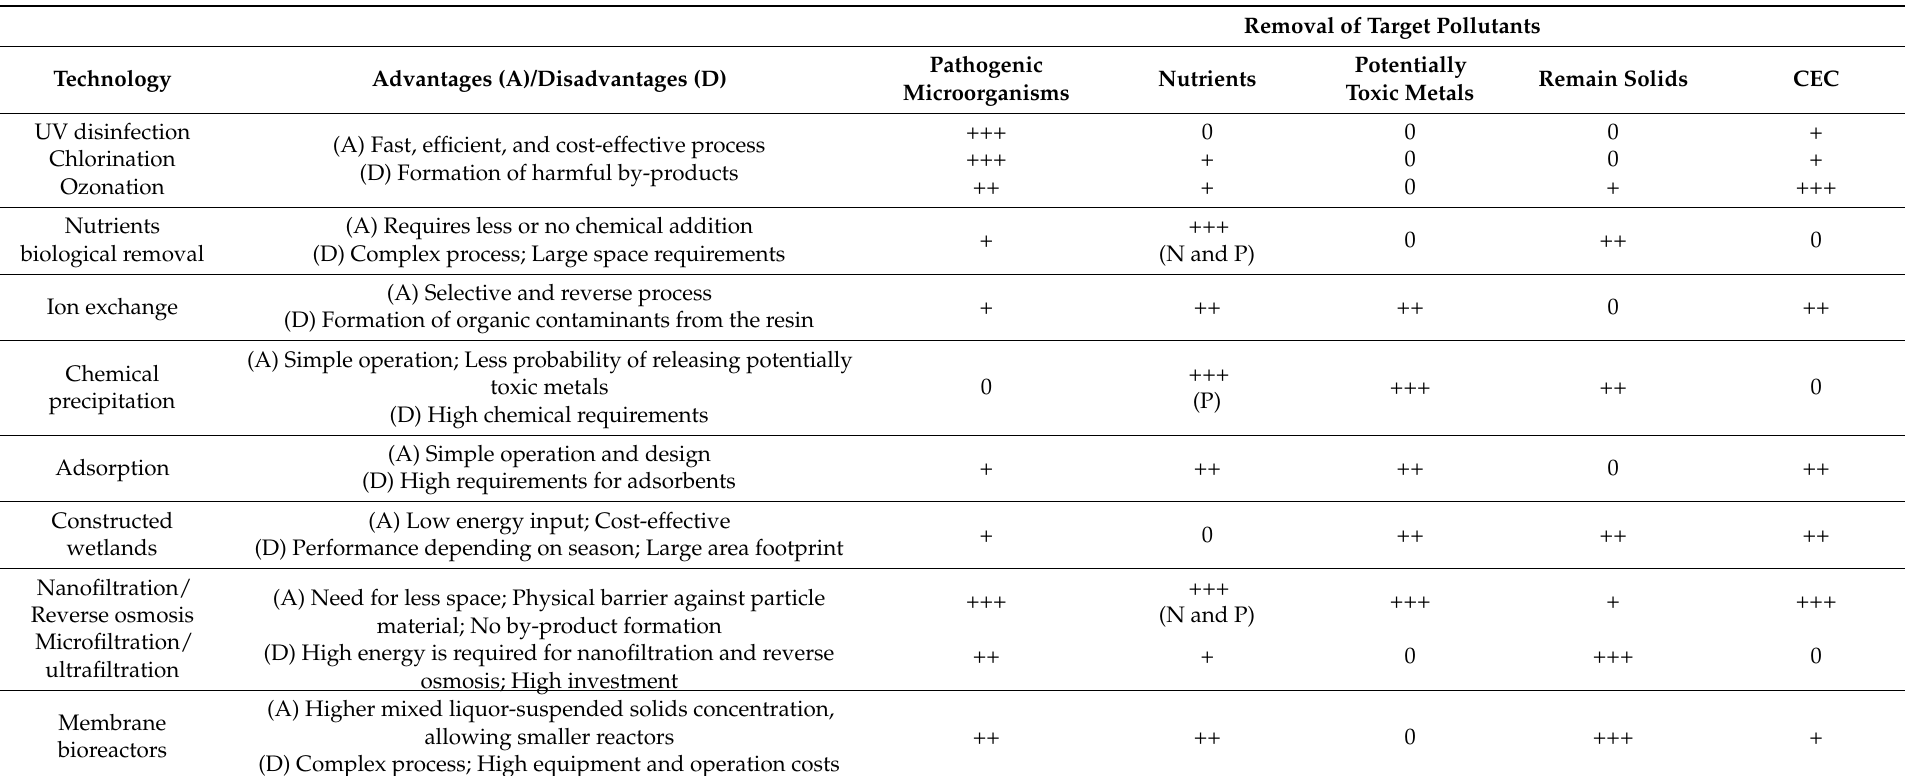
Table 7. Advantages, disadvantages, and potential to remove target pollutants of different technologies